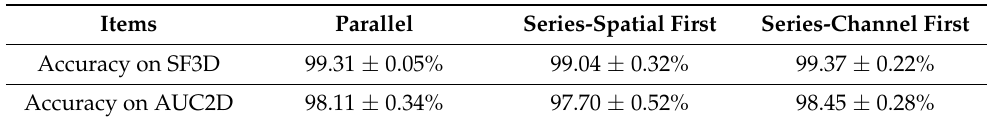
Figure 12. Three configurations of the attention module: series with channel first, series with spa- tial first, and parallel. first, and parallel. Table 6. Attention module configure